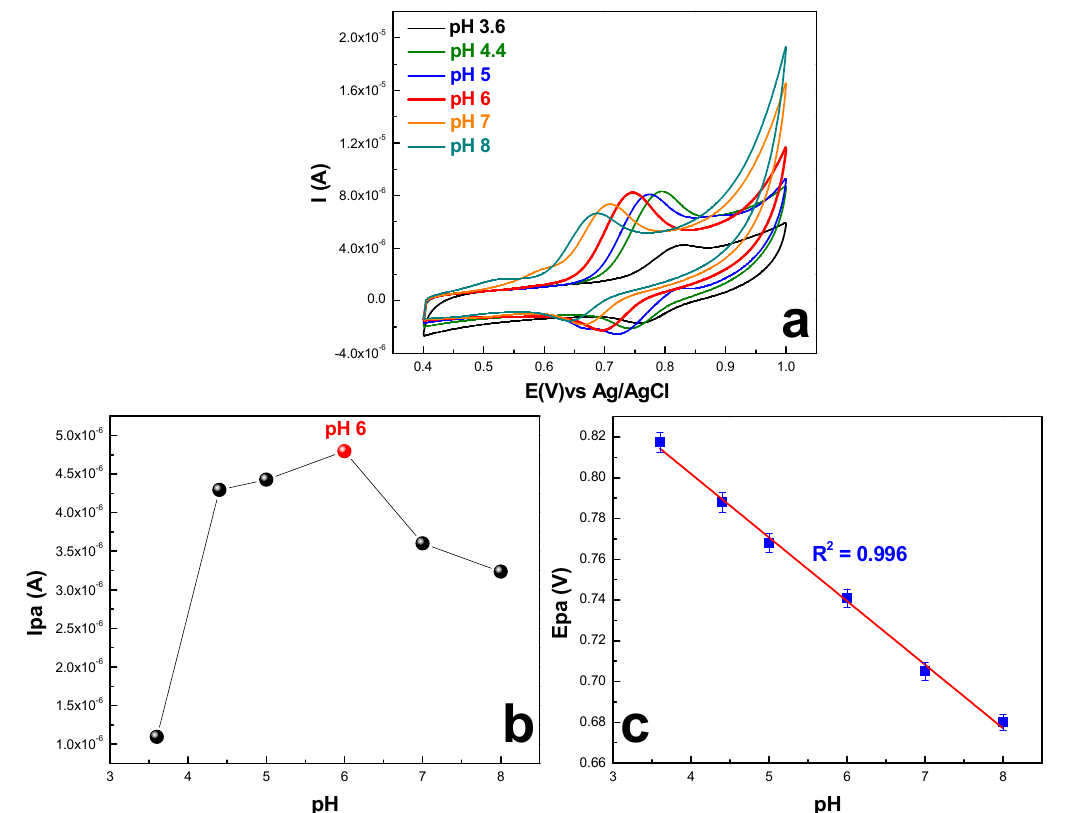
Figure 3. ( a ) CVs recorded with GR-exf/GC in buffer solutions containing 100 µM SY at different pH values (3.6; 4.4; 5.0; 6.0; 7.0 and 8.0); scan rate: 10 mV/s; ( b ) Anodic peak current versus pH value; ( c ) Plot of anodic peak potential versus pH value .